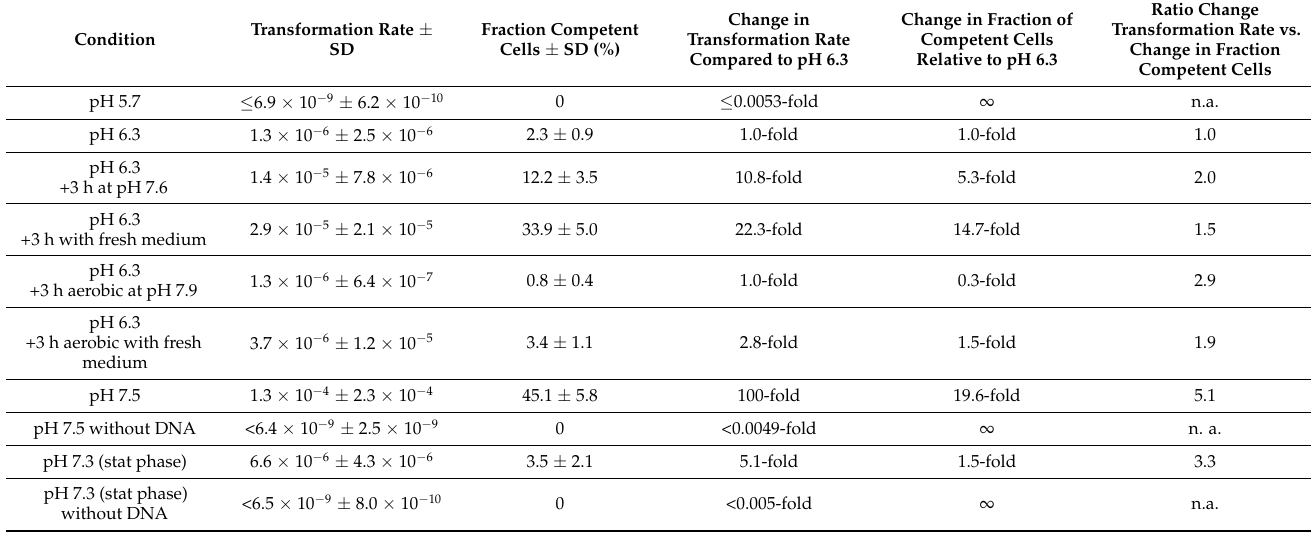
Table 1. Transformation rates of C. jejuni correlate with the fraction of competent cells, harboring at least one fluorescent DNA focus.